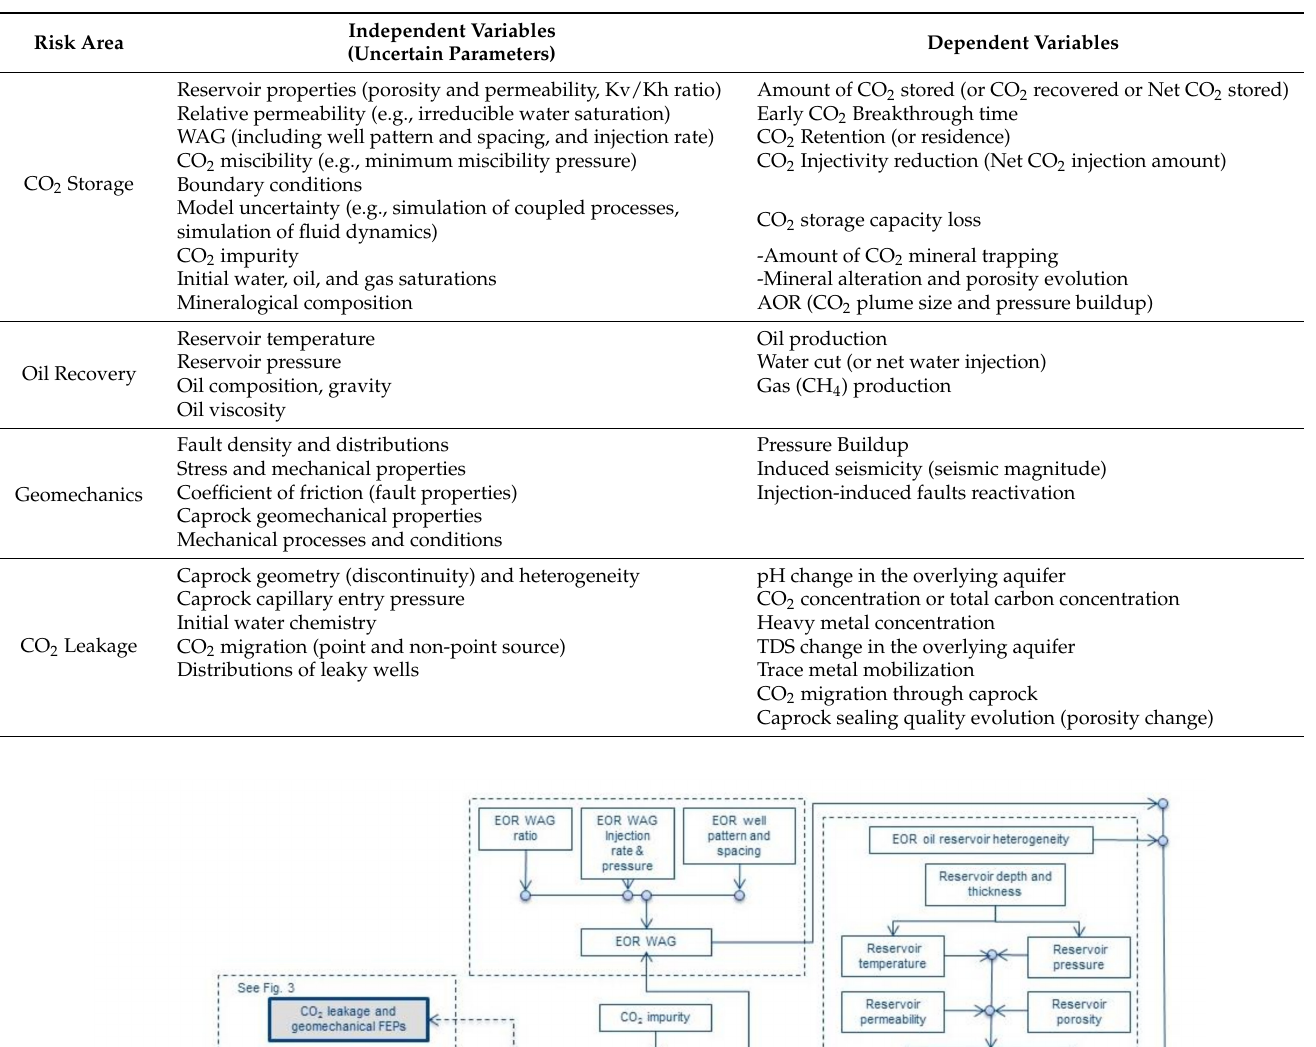
Table 3. Risk matrix components including independent and dependent variables.